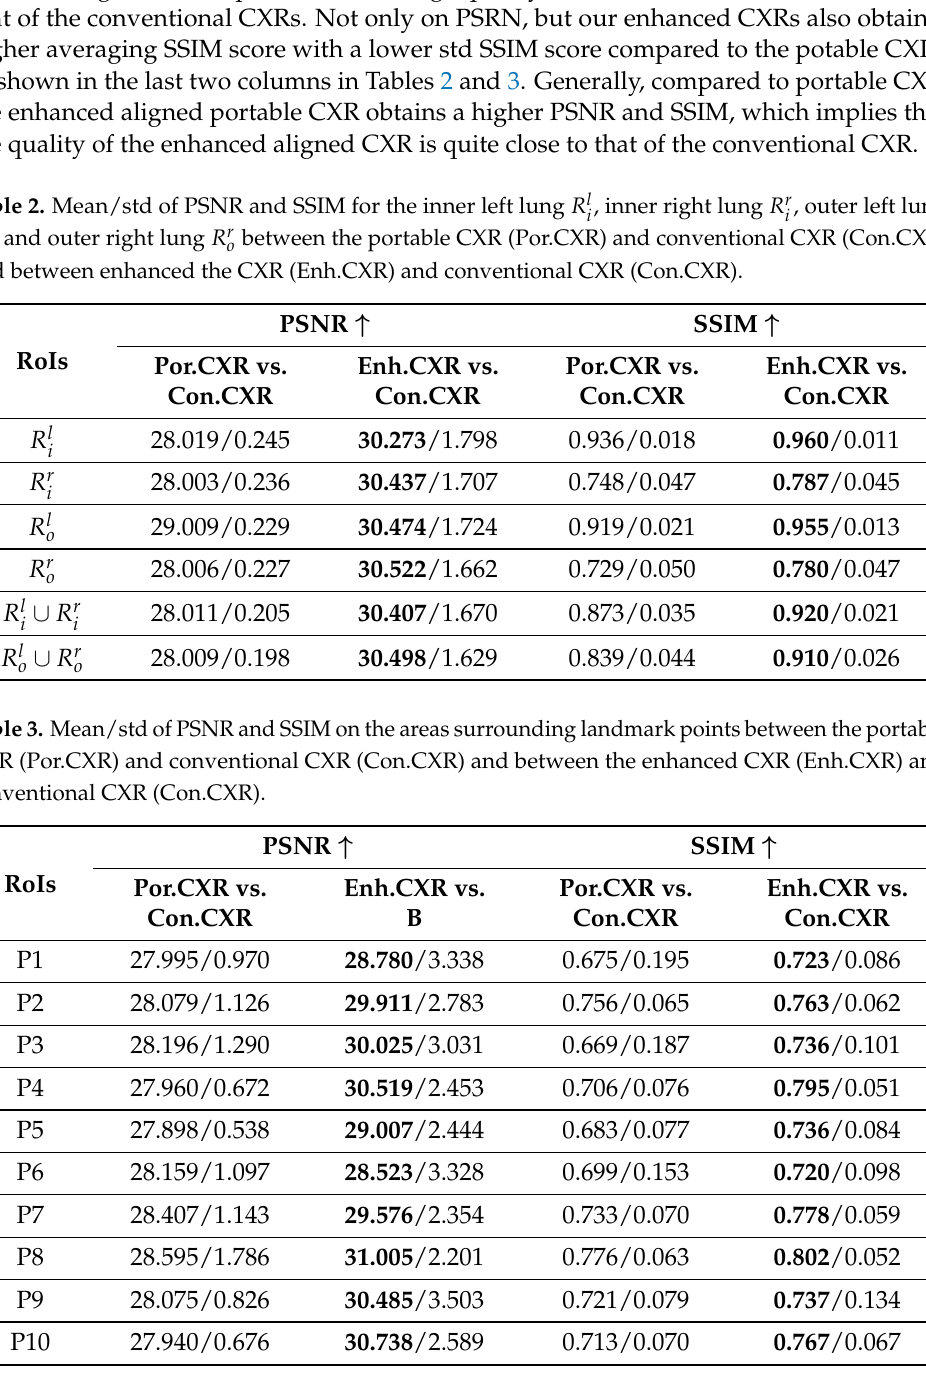
, inner right lung R r , outer left lung i i